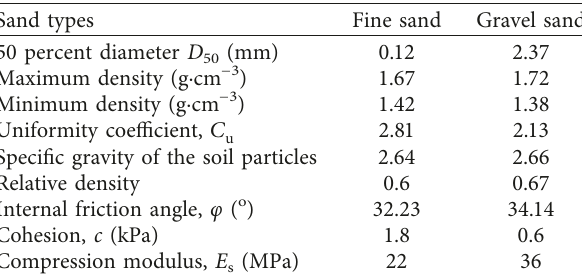
Table 2: Physical properties of the model